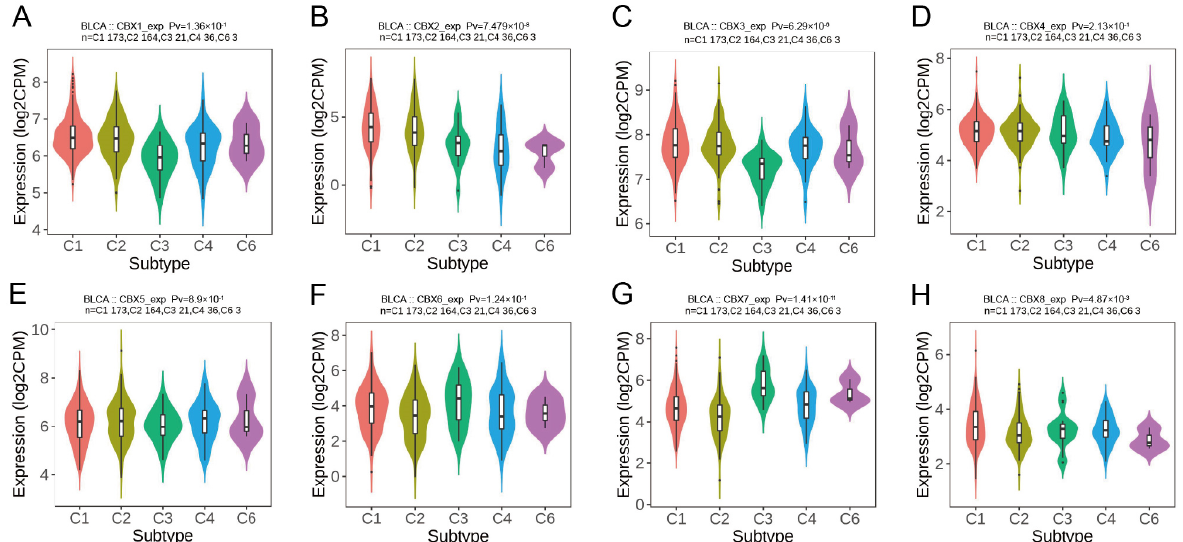
Figure 2. Associations between the expression of CBX mRNA and immunological subtypes throughout BLCA in TISIDB ( A ) CBX1; ( B ) CBX2; ( C ) CBX3; ( D ) CBX4; ( E ) CBX5; ( F ) CBX6; ( G )